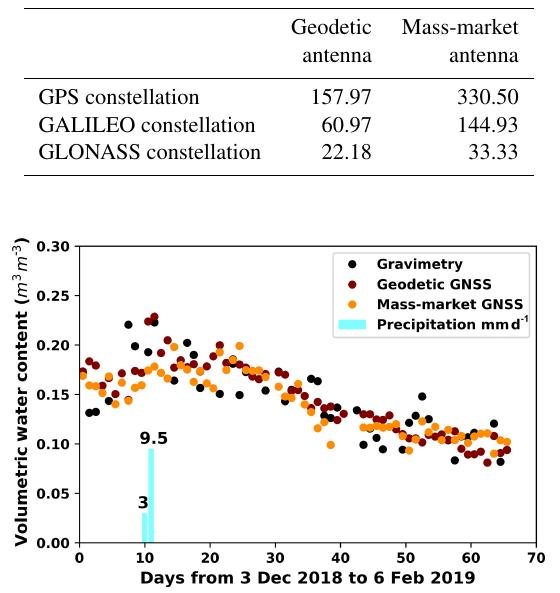
Figure 11. GPS comparison of daily soil moisture. The results of the geodetic and mass-market antennas are compared with the ref- erence gravimetric data set.